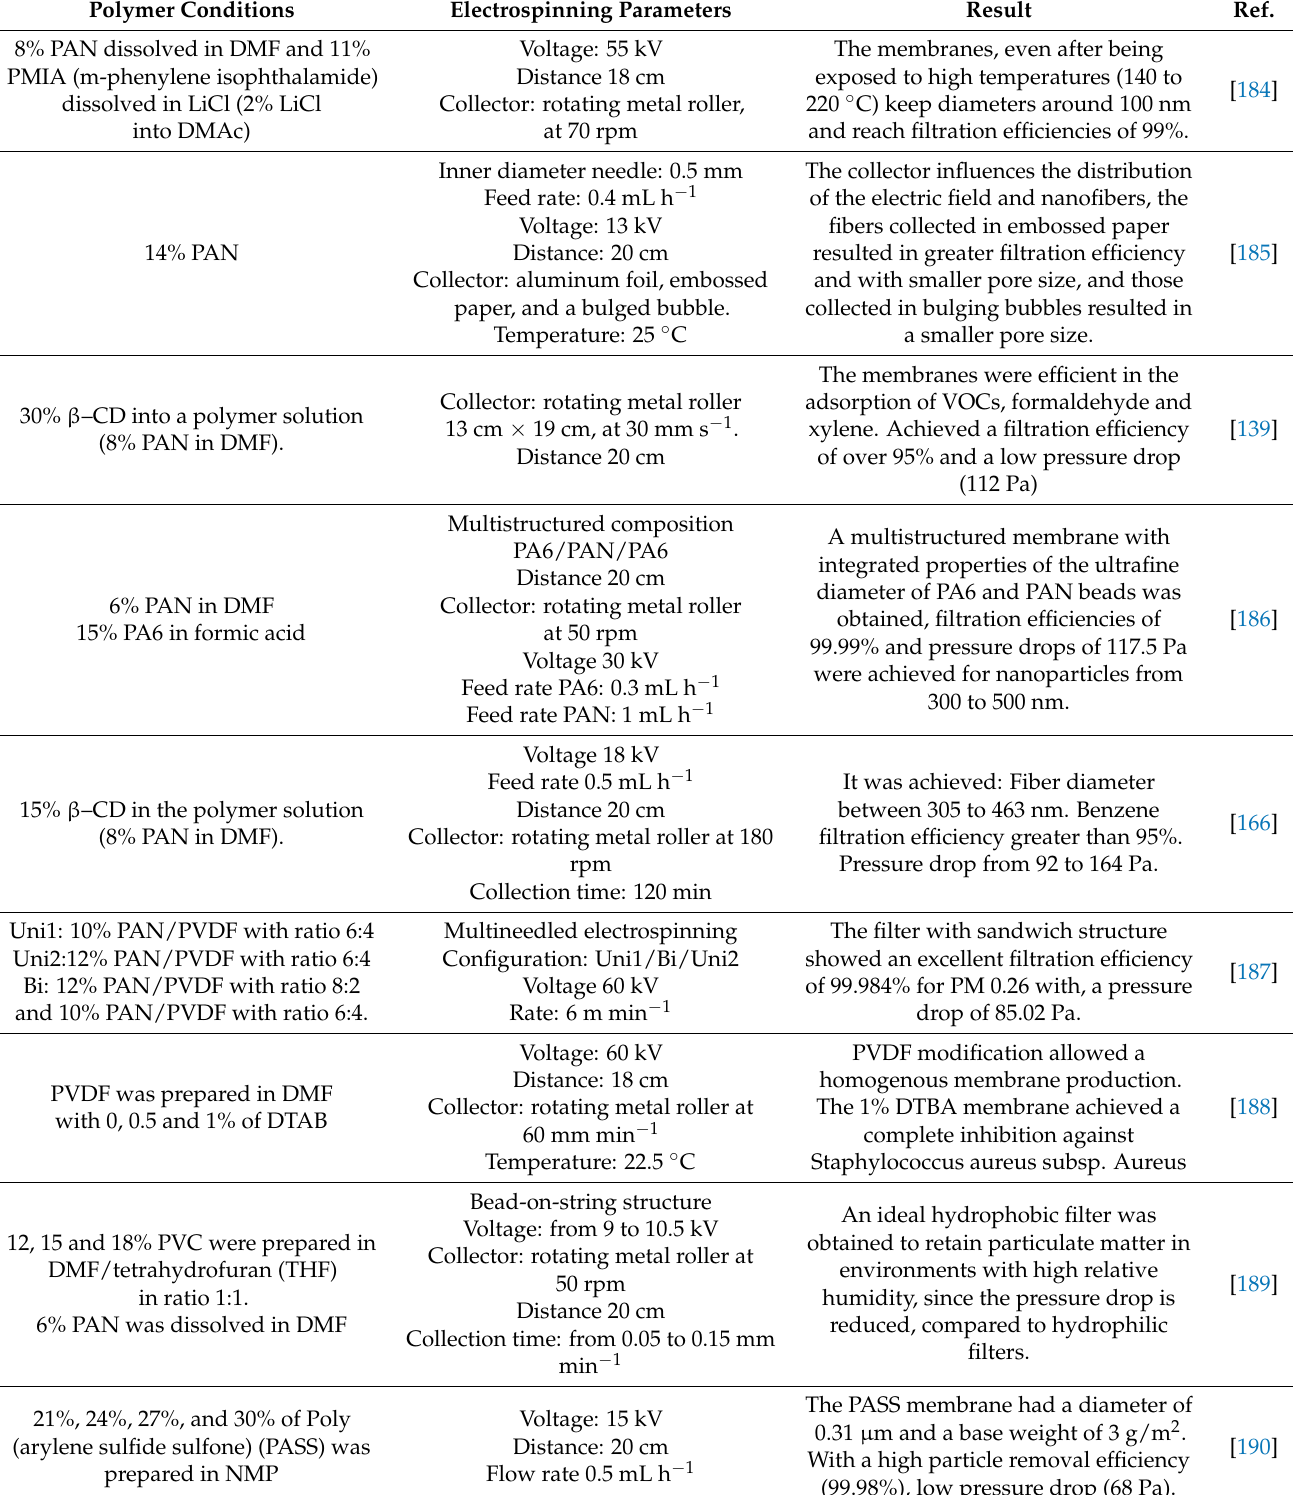
Table 1. Additional research concerning electrospinning for air